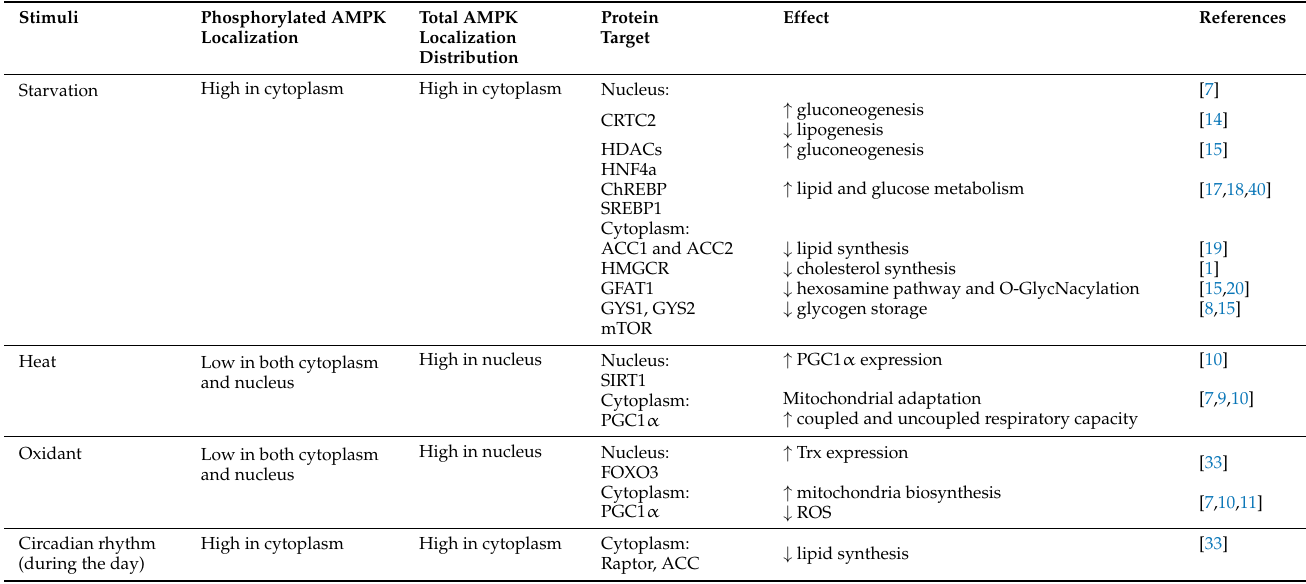
Table 1. The distribution of total and phosphorylated AMPK and the protein target activated during different stimuli.